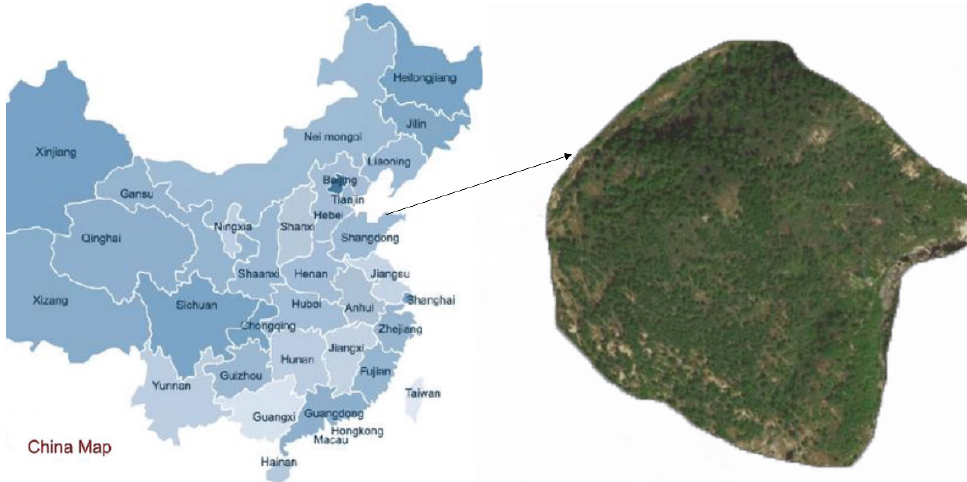
Figure 1. Location information of the study area.